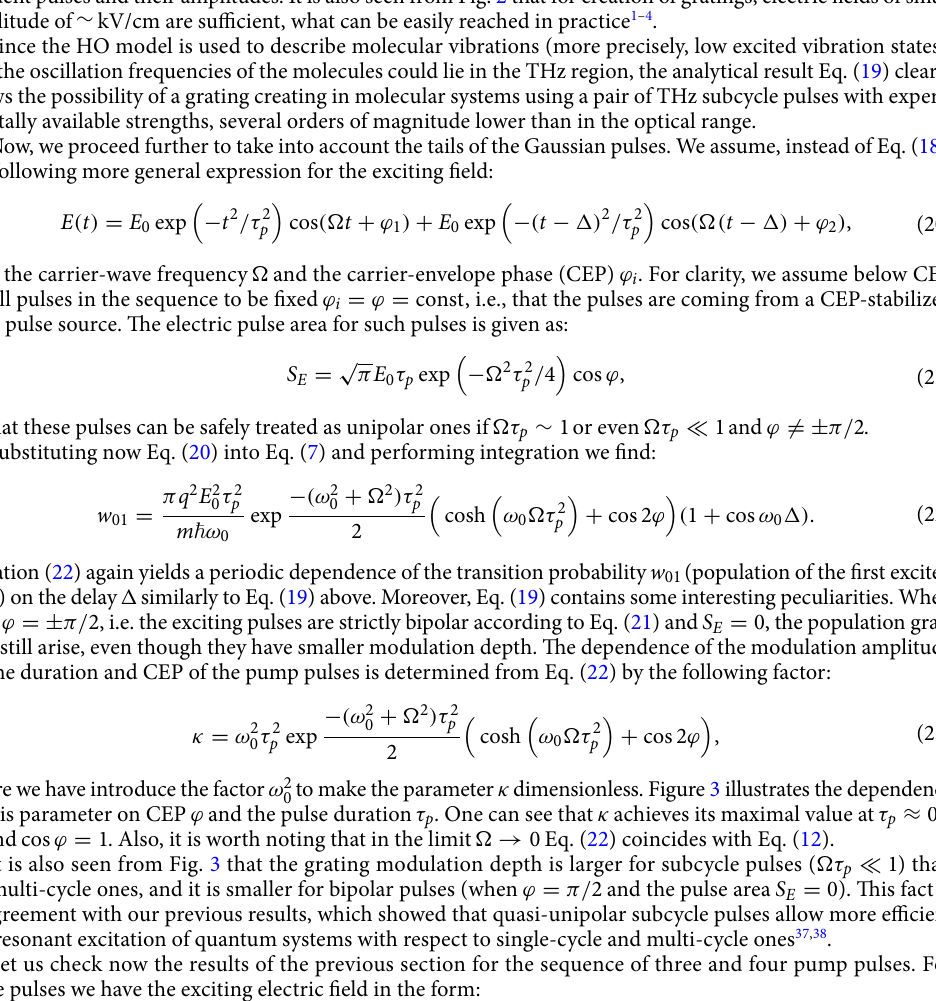
19.2 Debye. This figure 3 ps, ω 0 / 2 π 0.97 THz, d 01 = = =